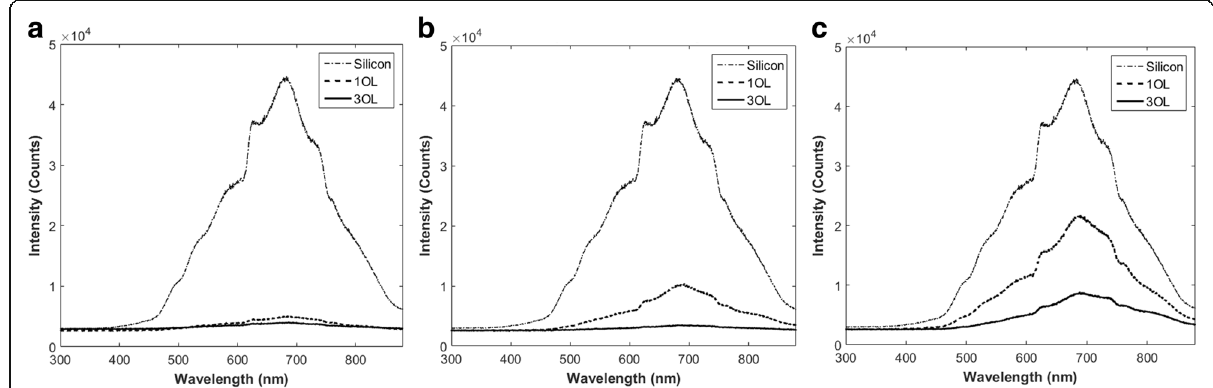
Fig. 4 Light reflection of laser-treated silicon samples at one and three overlaps (OL) and at line spacings of a 0.025, b 0.10, and c 0.15 mm